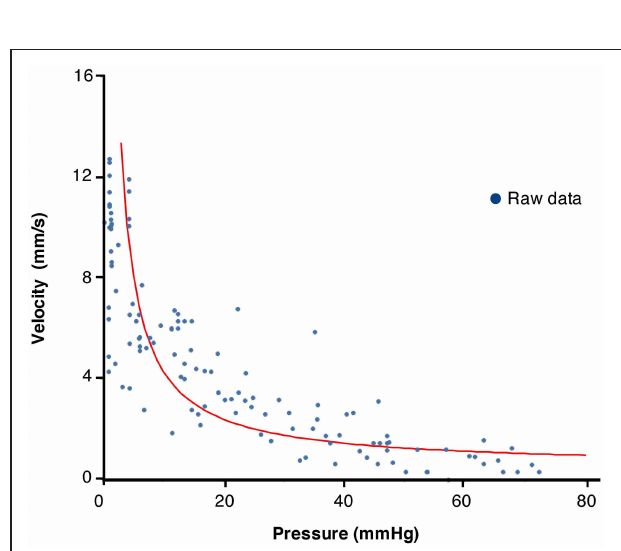
FIGURE 8 | Plot of values of velocity of contraction vs. pressure from 10 periods chosen from the composite DPMap in Figure 7 during isotonic to isometric contractions. The plotted values were fitted by a rectangular hyperbole according to the method described in the method section. The curve shows the expected inverse relation between pressure and velocity of contraction described originally by